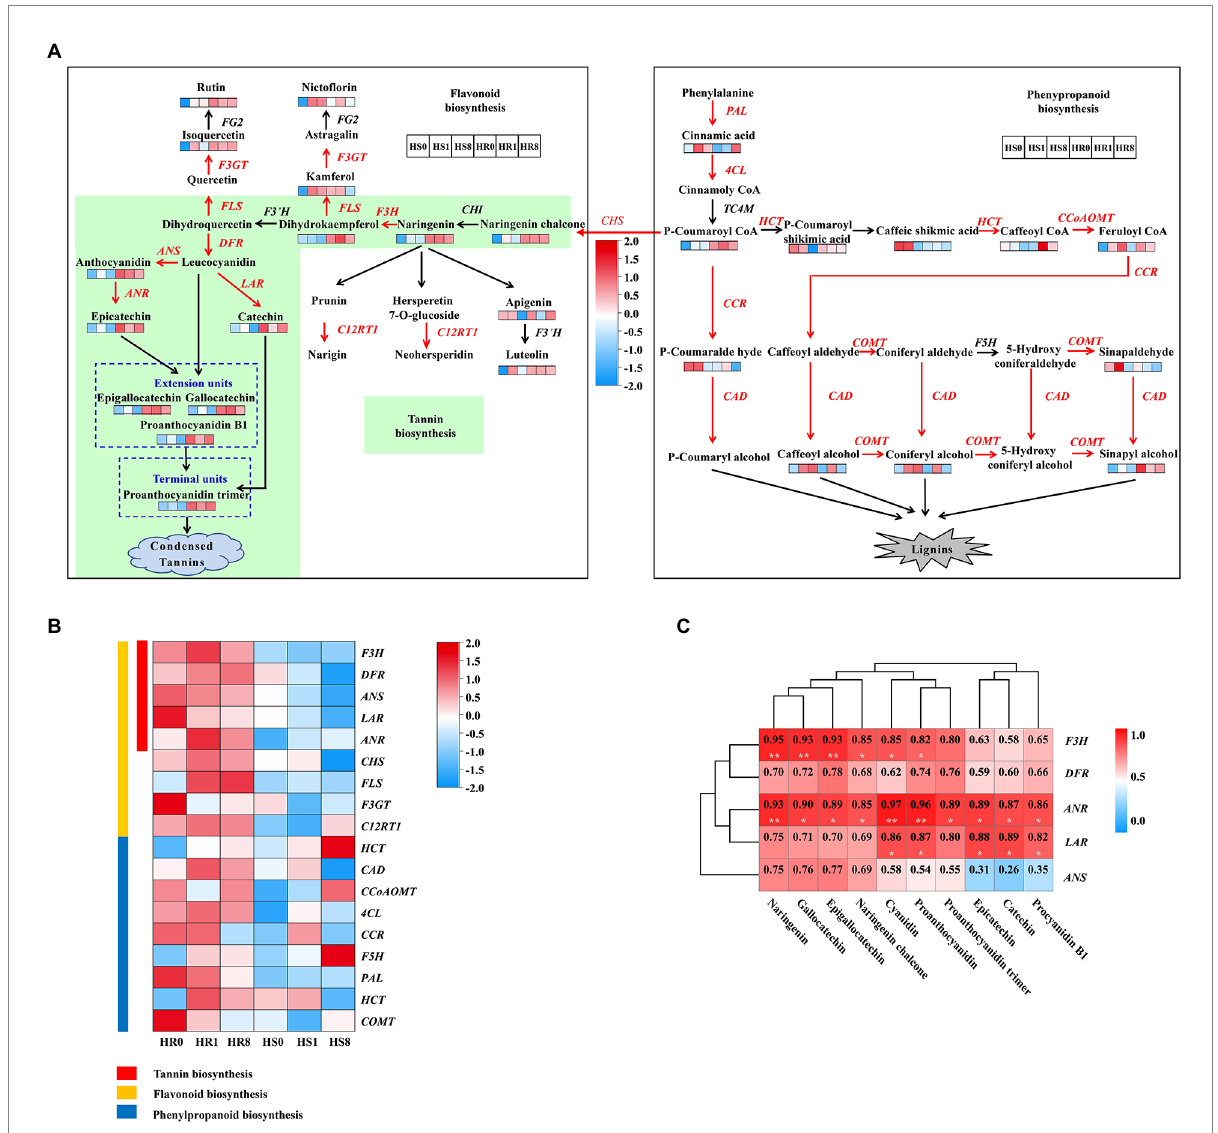
FIGURE 2 Changes in expression of genes and abundances of metabolites related to flavonoid/phenylpropanoid biosynthesis during TSSM infestation on HR and HS cultivars at different infestation time points [0 d (HR0 and HS0), 1 d (HR1 and HS1), and 8 d (HR8 and HS8)]. (A) Summary of pathways of flavonoid/phenylpropanoid biosynthesis. Heatmaps are shown where the abundance of the metabolite changed significantly between the infestation times of HR and HS samples. Genes that were identified as being differentially expressed are indicated in red, definitions of the groups are presented in the black and white frames. (B) Heatmap of flavonoid/phenylpropanoid biosynthesis genes significantly affected during TSSM infestation. (C) Correlation between the DEGs and DEMs in the tannin biosynthesis pathway. Single asterisk and double asterisk indicated significant ( p < 0.05) and extremely significant level ( p < 0.01),